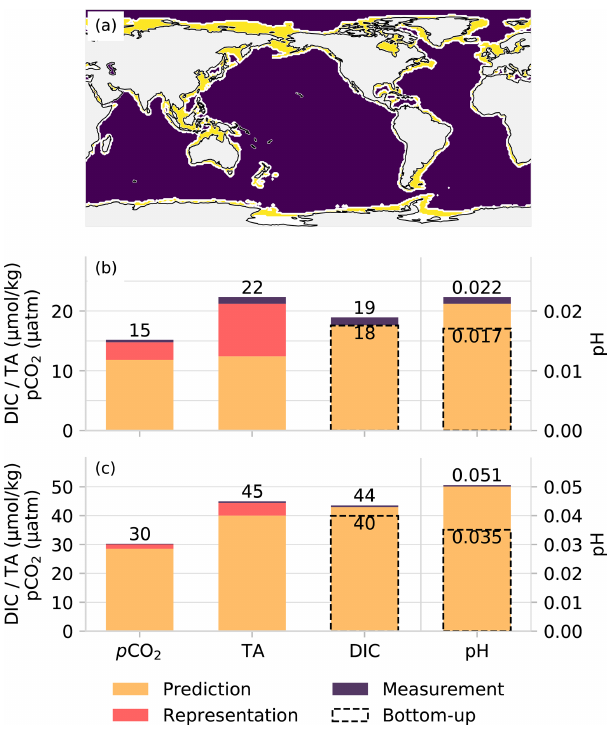
Figure 7. A comparison of propagated uncertainties with indepen- dent uncertainties as an assertion of the validity of uncertainty esti- mates. The map (a) shows the separation between coastal and open ocean, panel (b) shows the error contributions in the open ocean, and panel (c) shows those in the coastal ocean. The total uncertainty has been broken into the three different components. Note that the values represented by the bar plots are not equivalent to values in Table 3 as the latter shows p CO 2 and TA total uncertainties for test data only, while the bar charts show total uncertainties for all data; further, the breakdown of the error contributions is proportional to the contribution of the sum of the squares (see Eq.